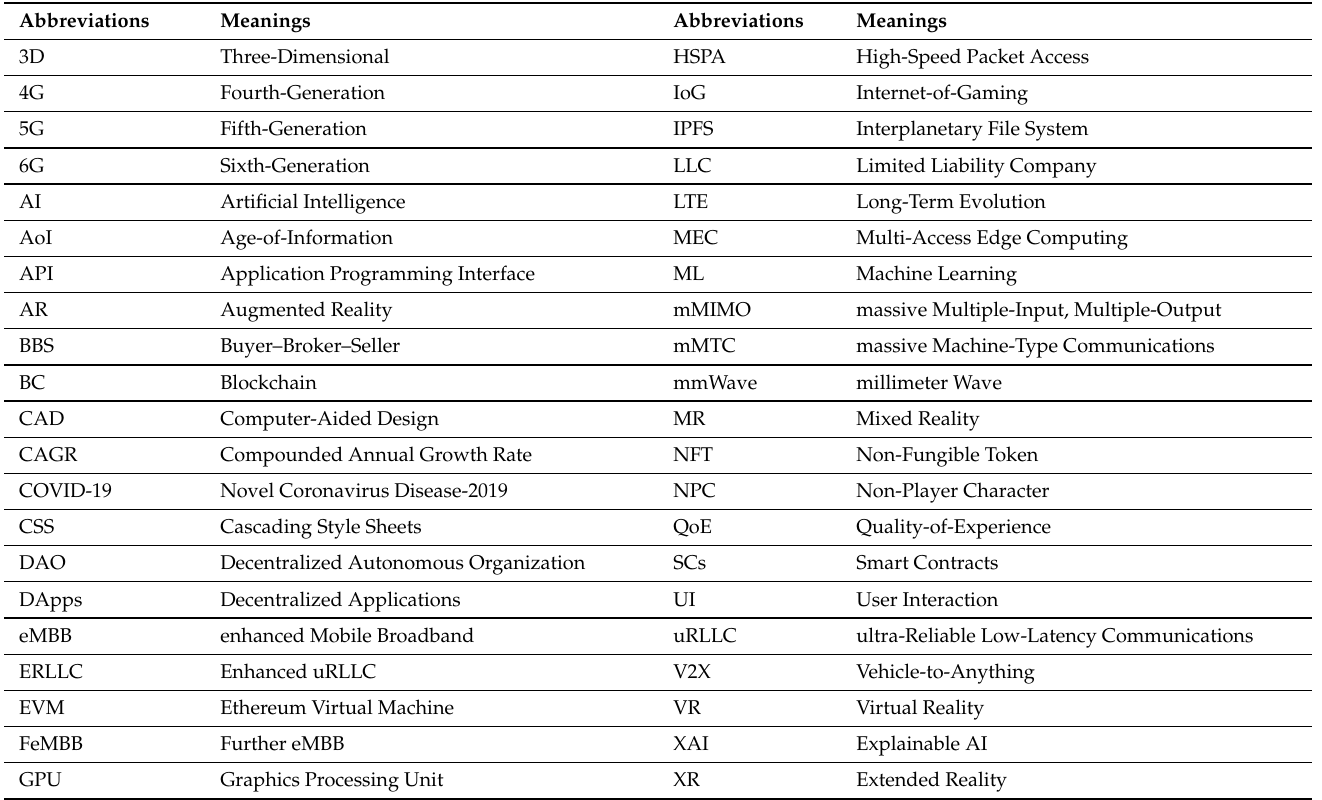
Table 1. Abbreviations and their